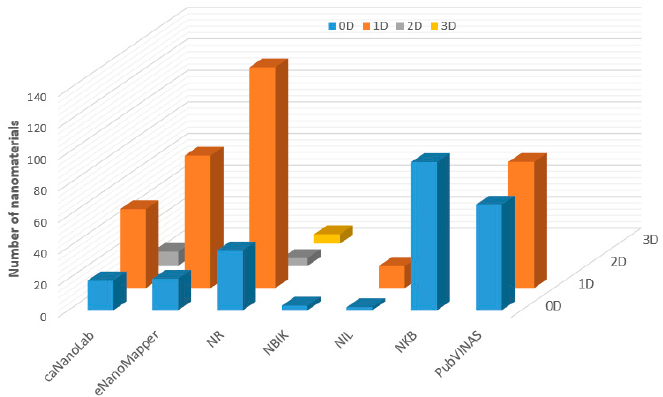
Figure 2. Number of carbon-based nanomaterials ( z -axis) of four shape types (depicted in different colors and marked at the y -axis) in the seven nanomaterial databases indicated on the x -axis.